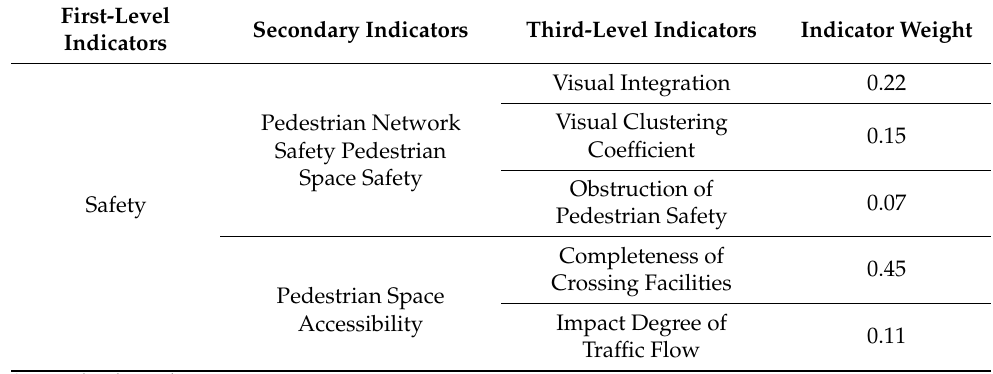
Table 3. Weights of pedestrian safety indicators of children’s school travel roads.